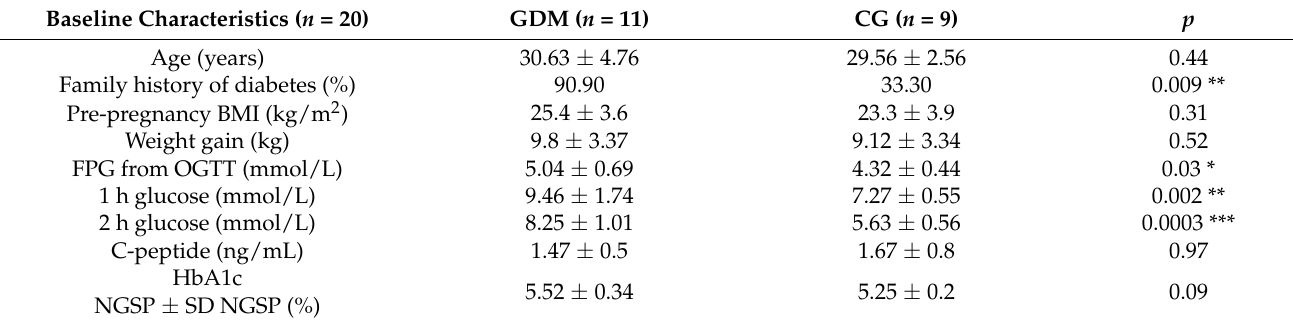
Figure 1. The comparison of the OGTT results in pregnant women with and without GDM (GDM/CG). The significance is set at p < 0.05. p value significance level: * 0.05, ** 0.01, *** 0.001. The baseline characteristics of study participants ( n = 20) are presented in Table 2. Table 2. Baseline characteristics of pregnant women